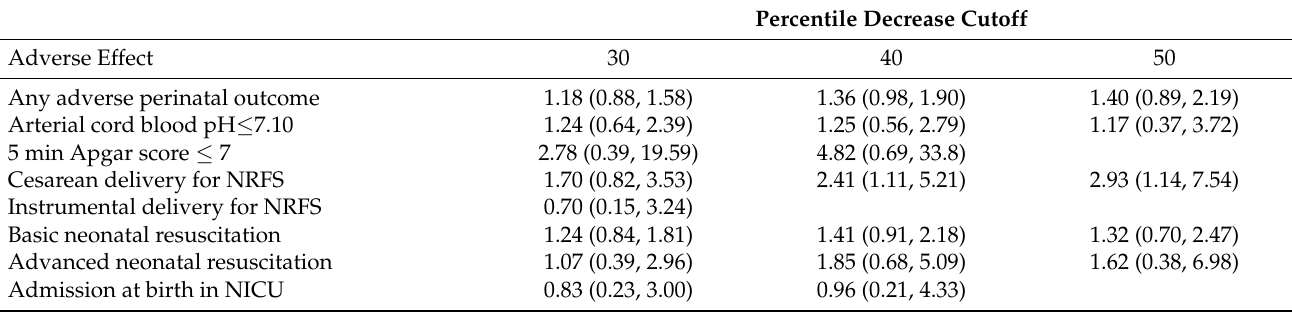
Table 4. Relative risk of each amount of percentile decreases relative to each APO in the AGA FGD